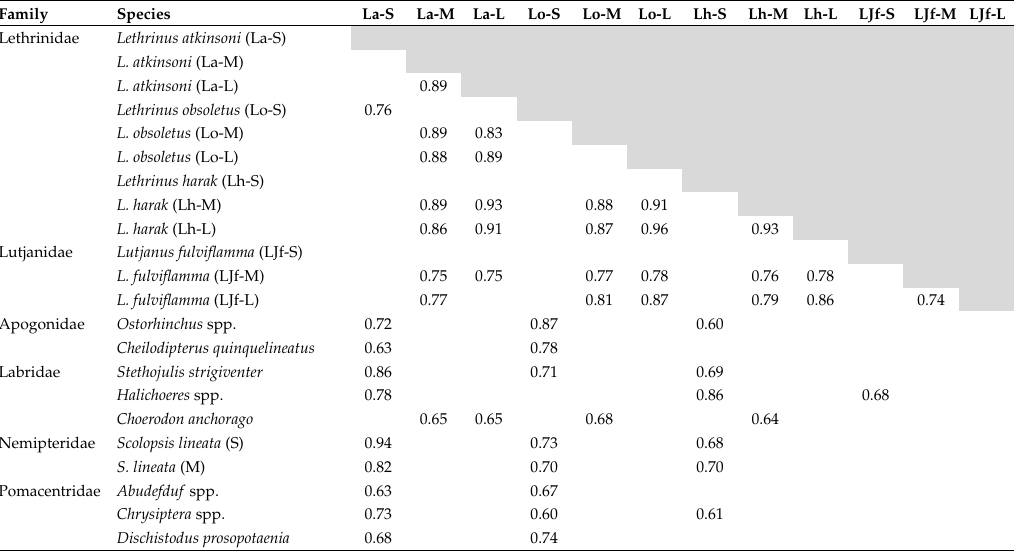
Table 4. Schoener’s index indicating the trophic niche overlaps among 1) the four target species in three different life history stages indexed by total length (S: Small, M: Medium, and L: Large) and 2) other potential competitors. Only index values greater than 0.60 have been shown.